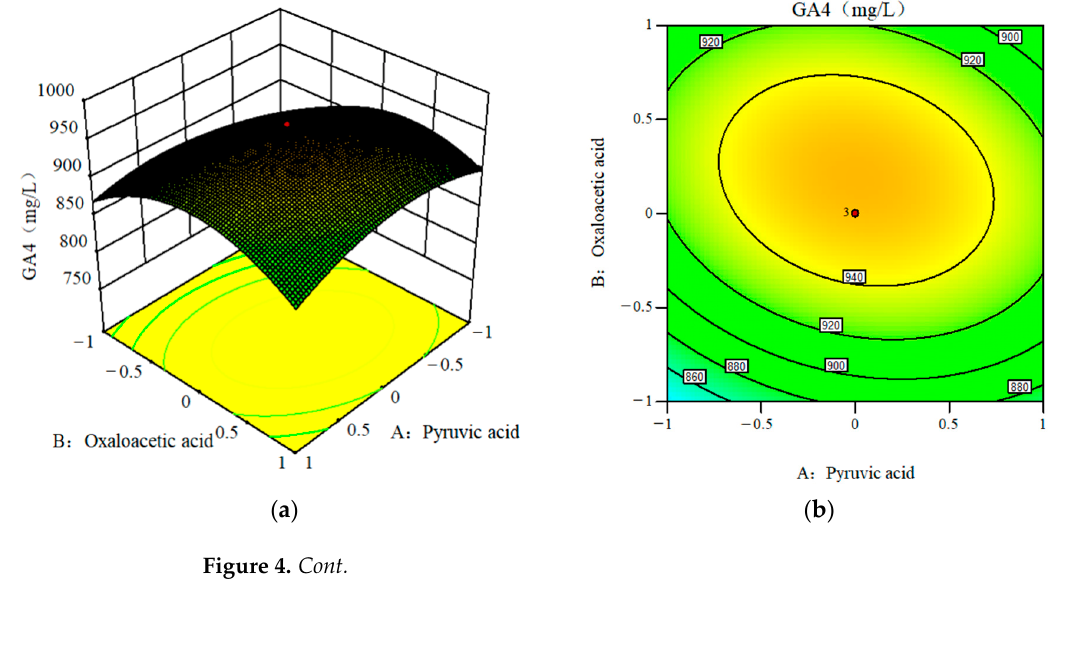
Table 10. Regression coefficients and their significance for response surface quadratic